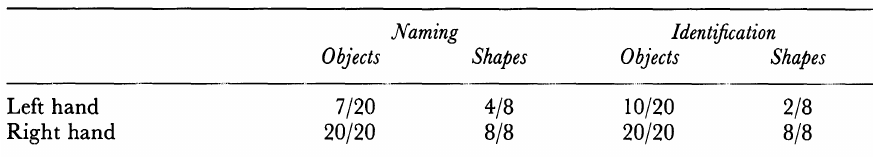
TABLE 4. Tactile naming and identification on oral command of objects and geometrical shapes